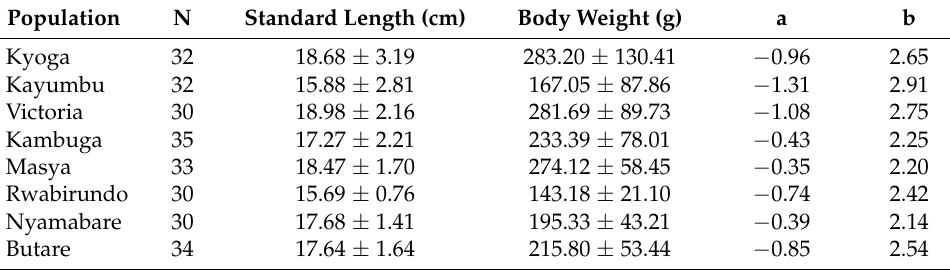
Table 2. Length–weight relationships of the different